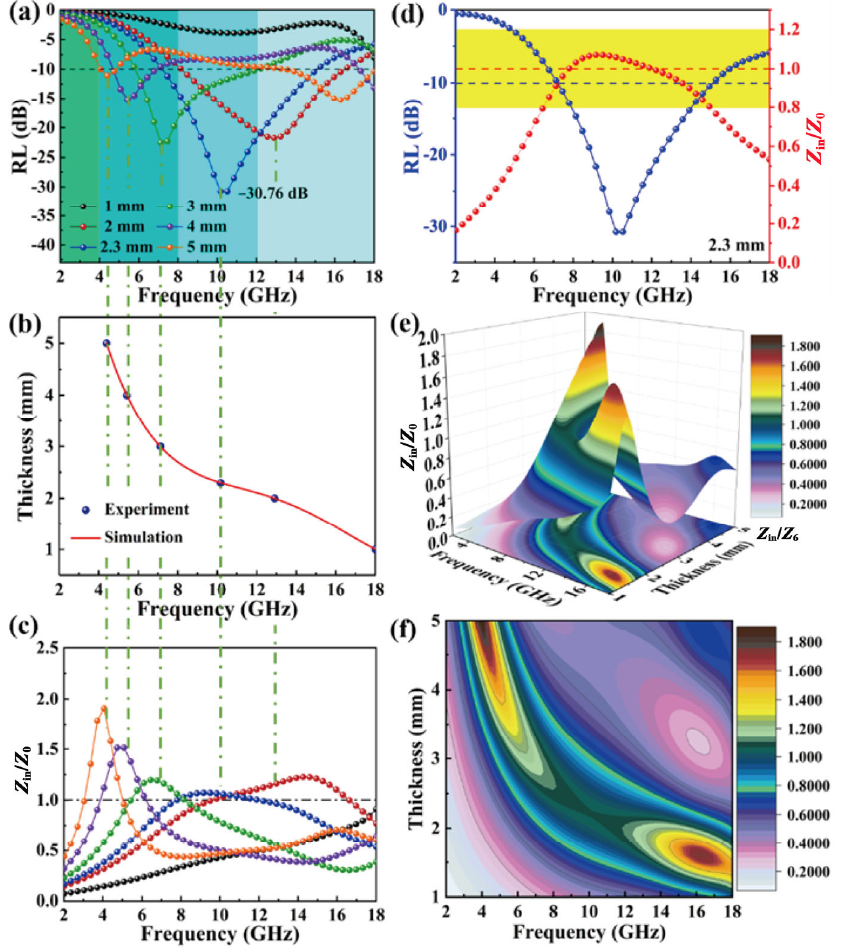
Fig. 7 (a) RL curves of T3, (b) relationship between the simulation thickness and peak frequency, (c) impedance matching rates ( Z in / Z 0 ) of T3, (d) relationship between RL min and Z in / Z 0 of T3 at a 2.3-mm thickness, (e) 3D plot of Z in / Z 0 of T3, and (f) 2D representations of Z in / Z 0 of